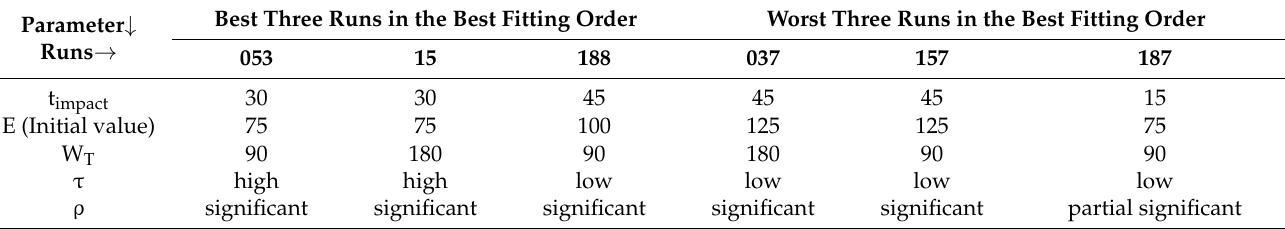
Figure 4. Actual Daily COVID-19 cases from March 2020 to November 2021 in KSA [72]. Table 4. Three best and worst runs